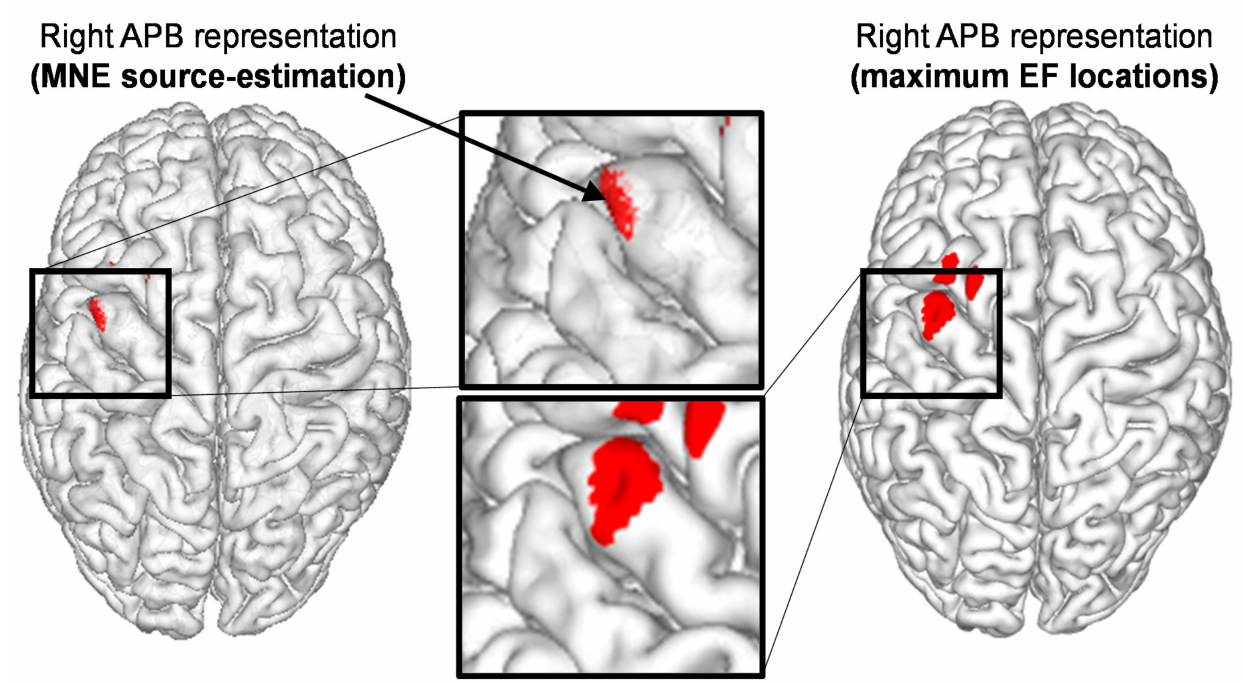
Figure 14. The MNE method ( left ) utilizes the spread of the EF at each stimulation point in addition to the MEP amplitude to estimate the source of motor activation, as opposed to the more conventional motor mapping approach not considering the spread of the EF associated with each stimulus ( right ) [204]. The active stimulation sites in the conventional motor map were outlined using the spline interpolation method